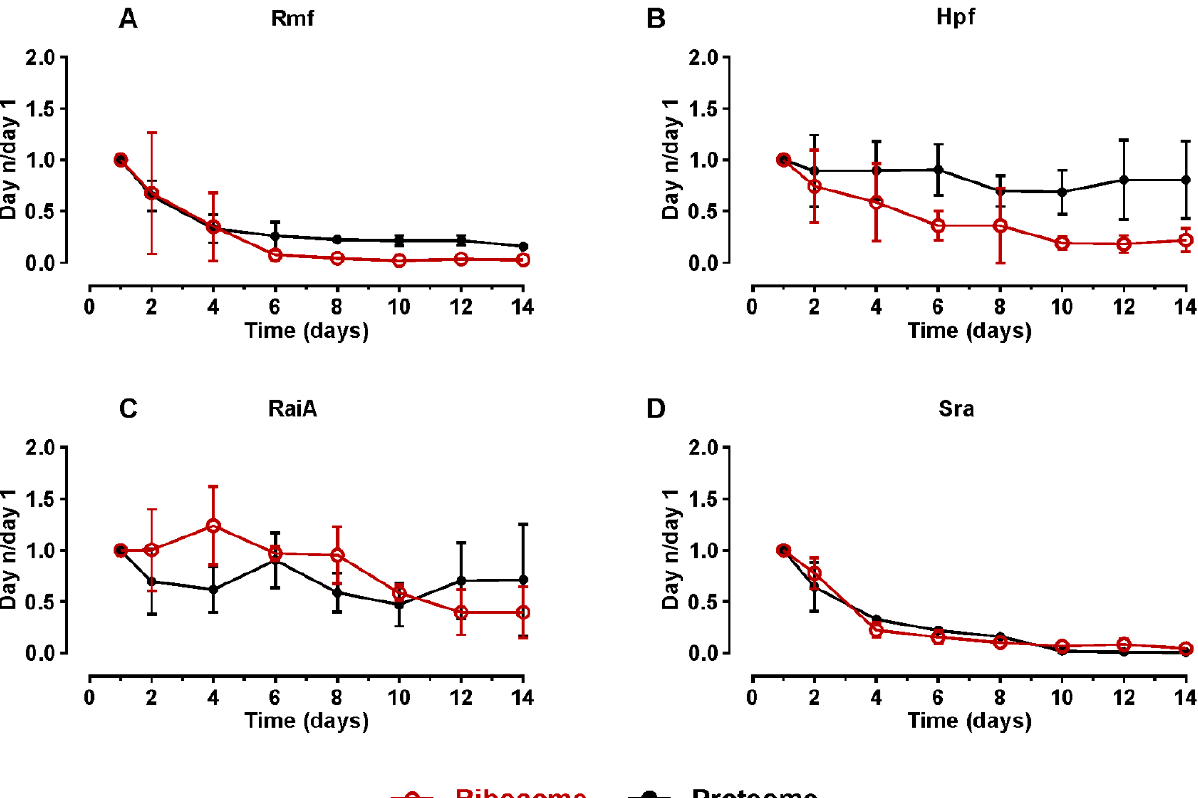
Figure 2. Translation hibernation factors in E. coli stationary phase ribosomes and proteome. E. coli batch culture was grown and samples were collected over the course of 14 days. Total protein and isolated ribosomes from the cell culture were analyzed using qMS. Quantity of Rmf ( A ), Hpf ( B ), RaiA ( C ), and Sra ( D ) in isolated ribosomes (red, empty) and proteome (black, filled) during stationary phase. Relative protein abundance compared to respective values on day 1 is shown (Y-axis). Values shown are the mean of three independent biological experiments with standard deviation (n = 3; mean ± SD).